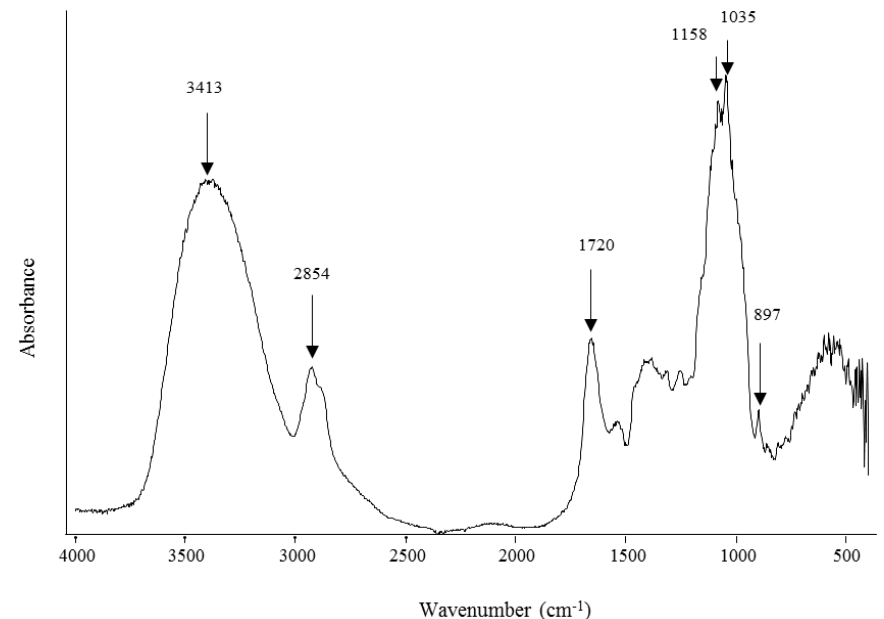
Figure 1. FT-IR spectrum of water extractable arabinoxylans.